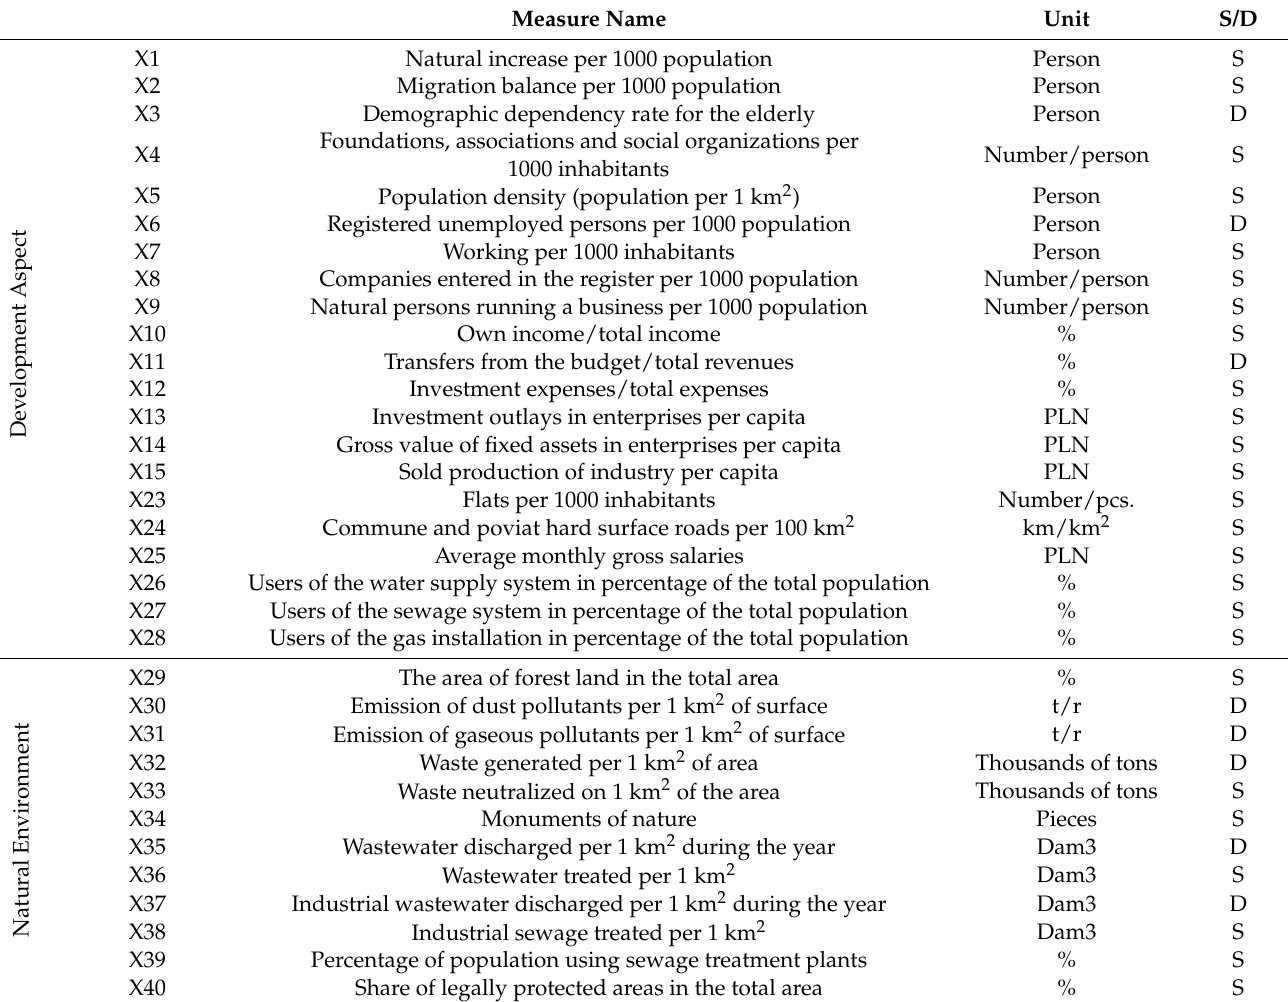
Table 1. List of variables describing the economic and social development as well as the natural environment and ecology of